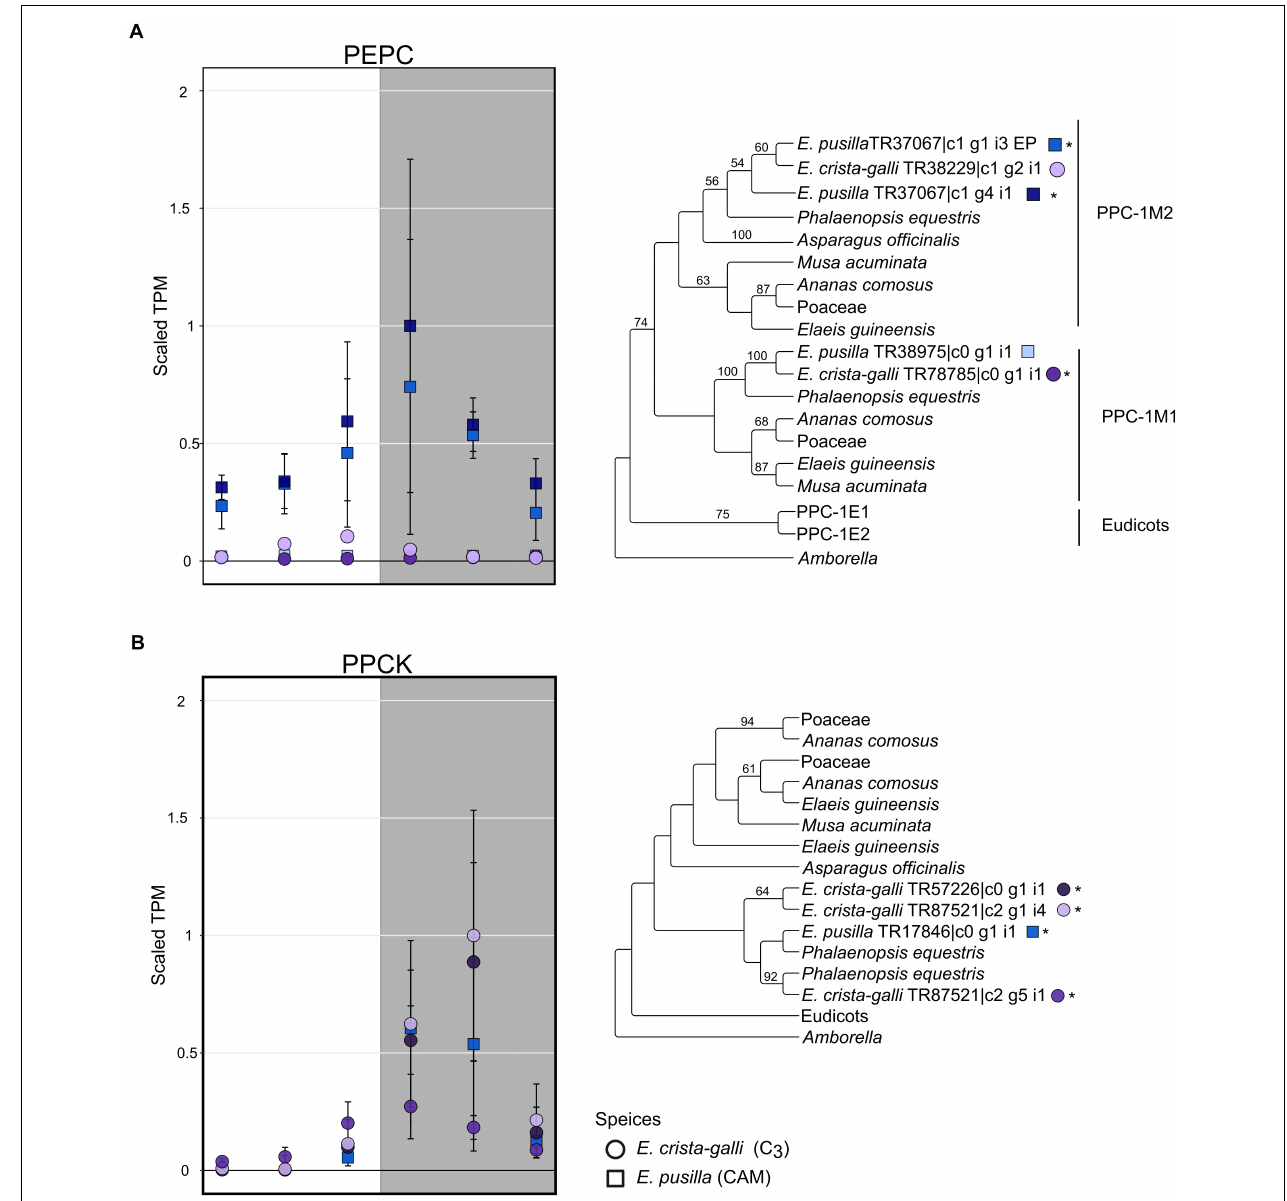
FIGURE 4 | Expression and gene tree of (A) phosphoenolpyruvate carboxylase (PEPC) and (B) PEPC kinsase (PPCK) in E. pusilla (squares, blue tones) and E. crista-galli (circles, purple tones). Different shades of color represent different assembled gene copies, and only transcripts that had a predicted open reading frame are shown in both expression plots and gene trees; asterisks next to transcripts in the gene tree indicate those transcripts had significant variation in expression across time. Average TPM and standard deviation, scaled to the maximum mean TPM value across all copies and species, are plotted for all six time points, with the gray background indicating nighttime